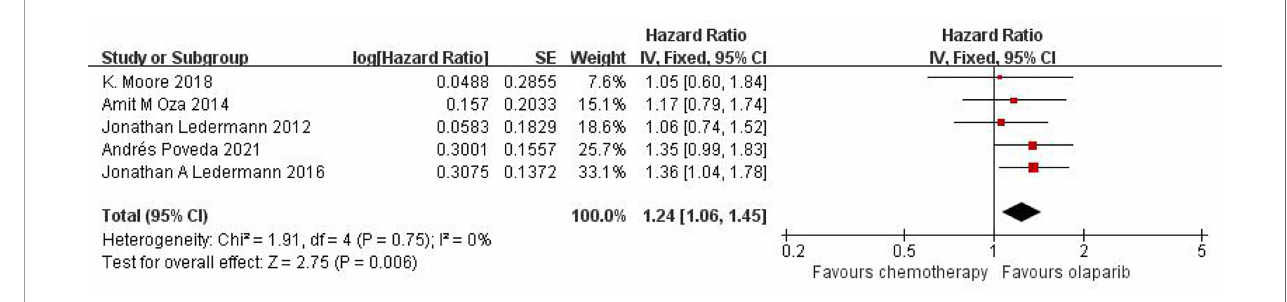
FIGURE 2 | Meta-analysis results of OS between control group and olaparib group.